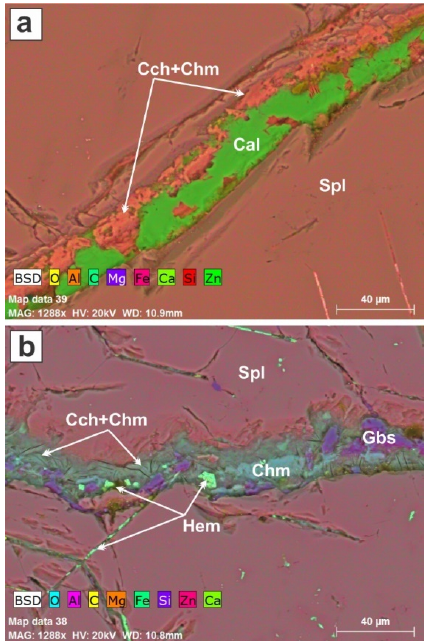
Figure 10. False-color EDS element-distribution maps of polymineralic micro-inclusions found in the two polished halves of the large single crystal of spinel that show an extensive development of secondary minerals.